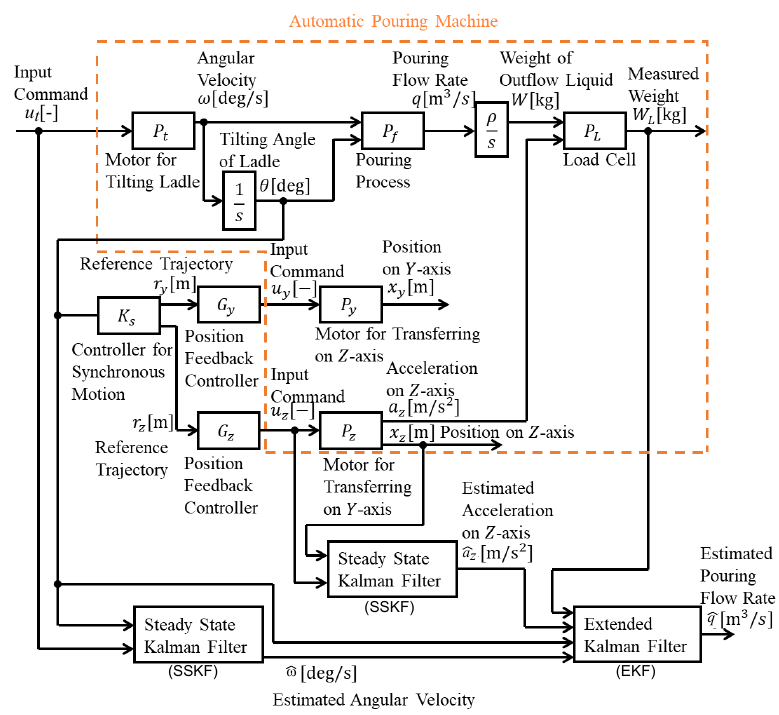
Figure 7. Block diagram of flow-rate estimation by